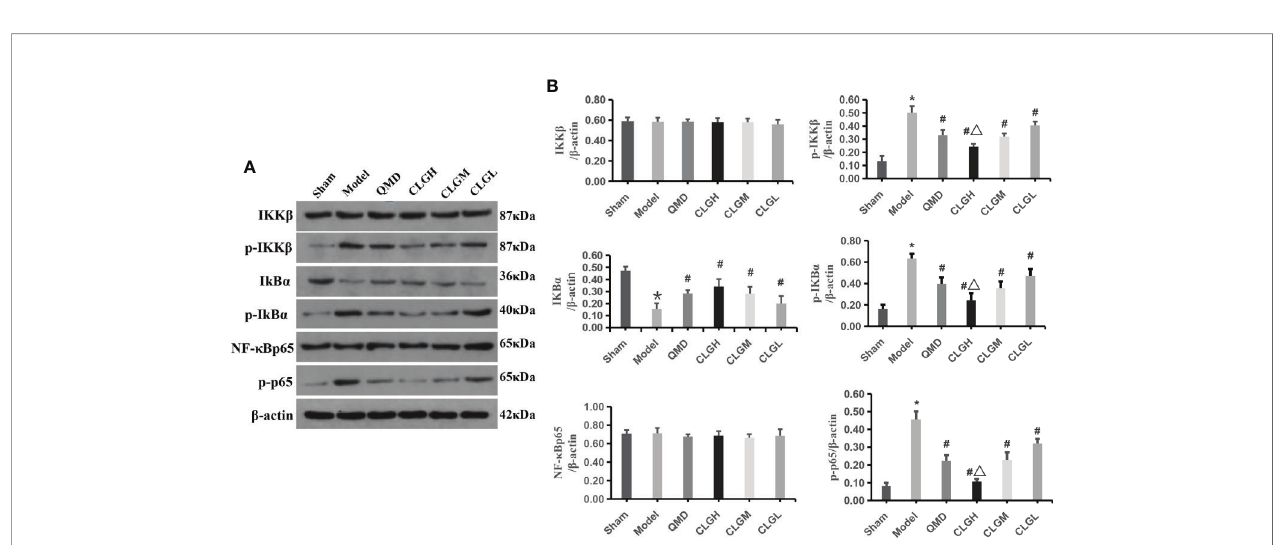
FIGURE 4 | The regulating effect of CLG on related proteins. (A) Inhibitory effects of CLG on the expression of I k B a (p-I k B a ), IKK b (p-IKK b ) and NF- k B (p-p65 NF- k B) in the transplanted tumor as determined by western blot analysis. (B) Semi quanti fi cation of the protein levels of I k B a (p-I k B a ), IKK b (p-IKK b ) and NF- k B (p-p65 NF- k B) in the sham, model and in the QMD, CLGH, CLGM, and CLGL groups. The data are mean ± SEM (n = 6). *P < 0.05 vs. sham, # P < 0.05 vs. Model, △ P < 0.05 vs. CLGL and CLGM.